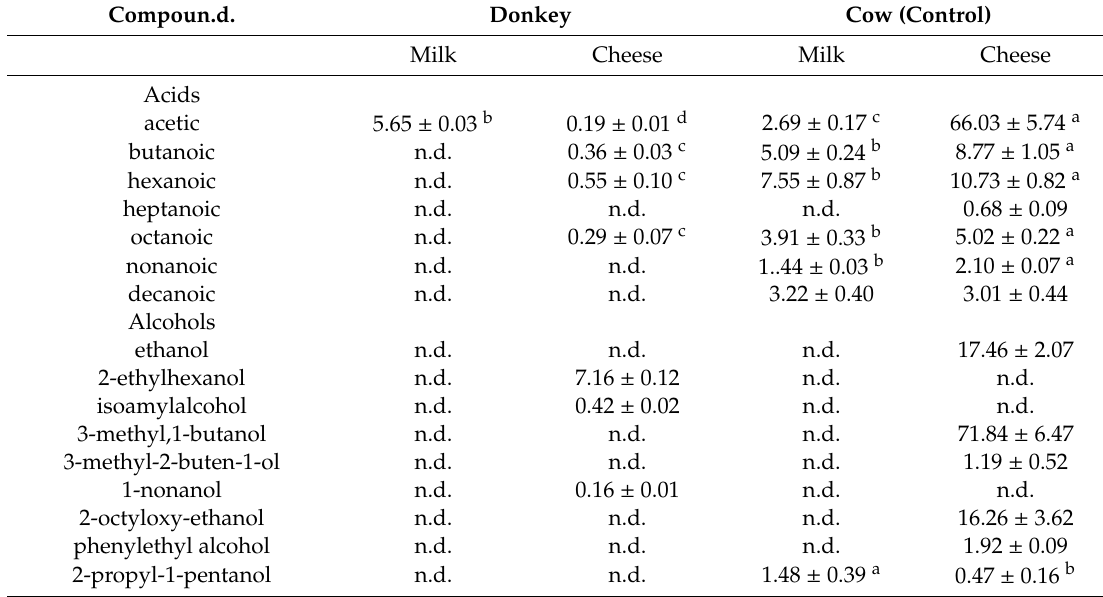
Table 3. Volatile organic compounds (VOCs) detected in milk and cheese ( µ g / kg ± SD).